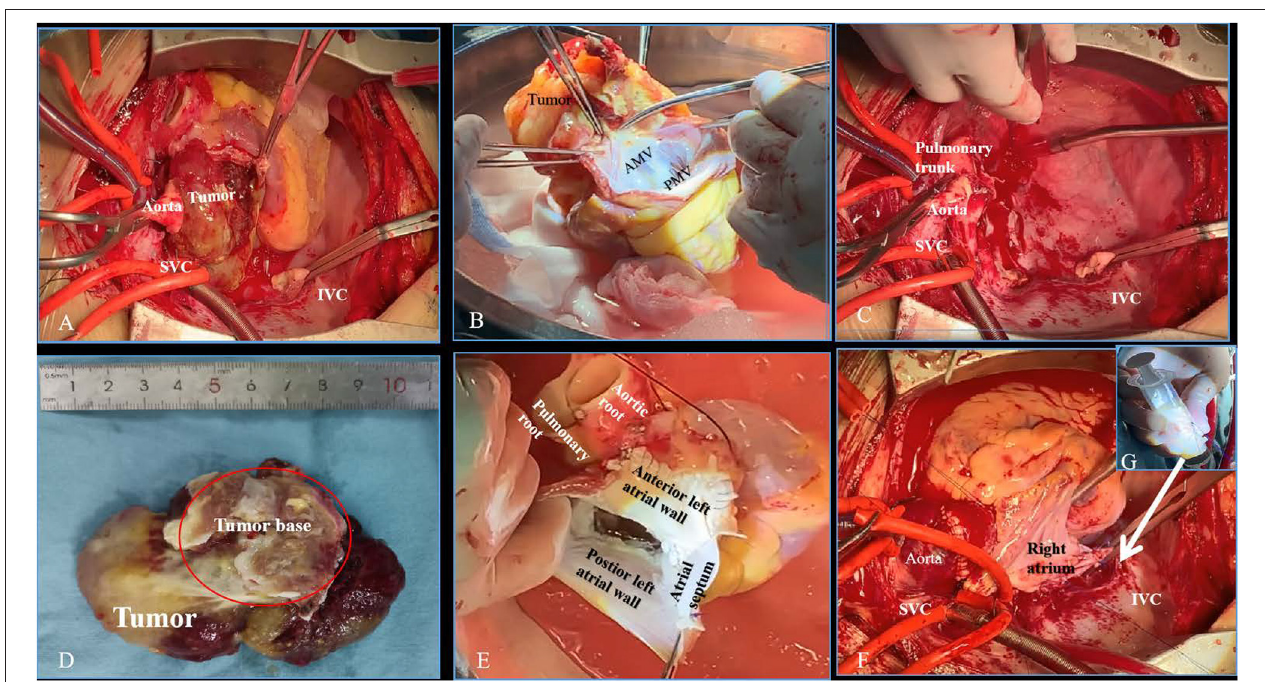
FIGURE 2 | Intraoperative images showing the key surgical steps of cardiac autotransplantation. (A) The aorta was divided and the roof of left atrium was then opened to explore the tumor. (B) The heart with tumor was excised and the tumor was removed ex vivo . (C) The pericardial cavity after the resection of the heart. (D) The tumor with broad base was completely resected. (E) Bovine pericardial patch was used to reconstruct the atrial septum and the anterior wall of left atrium. (F) Reimplantation of the heart to the body. (G) Self-constructed bovine pericardial tube. SVC, superior vena cava; IVC, inferior vena cava; AMV, anterior mitral valve; PMV, posterior mitral